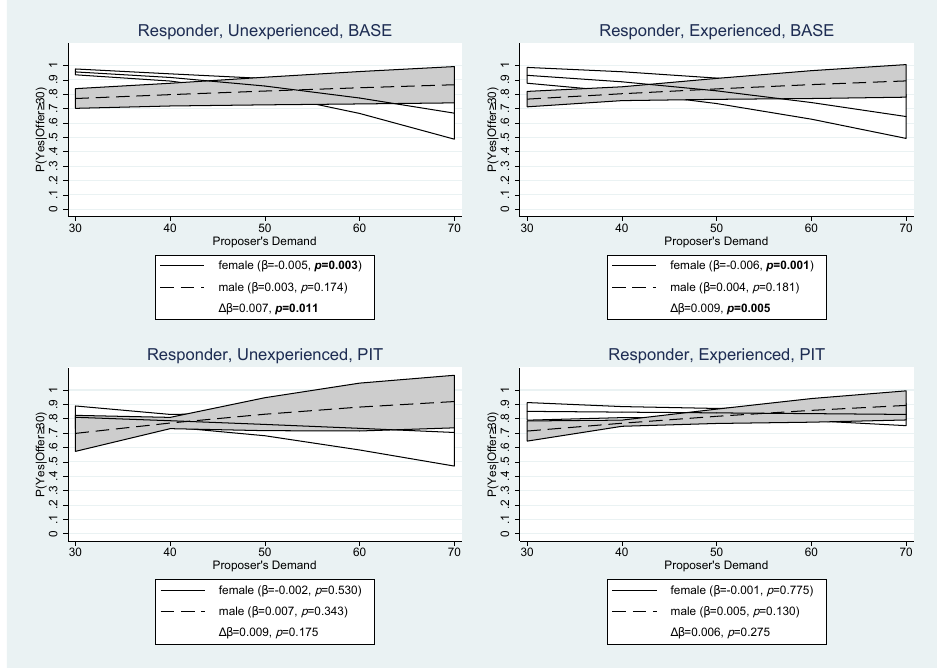
Figure 7. Responder Voting Behavior: Proposer’s Demand. The graphs show the responder’s average probability to vote “yes” on an offer ≥ 30 tokens, given the proposer’s demand in tokens by experience, treatment, and gender. β and ∆ β are the marginal effect of the proposer’s demand and the differential slope of Gender { 1 = male } estimated by a random effects probit panel regression. p is the significance level. Shaded areas represent 90% confidence intervals around the